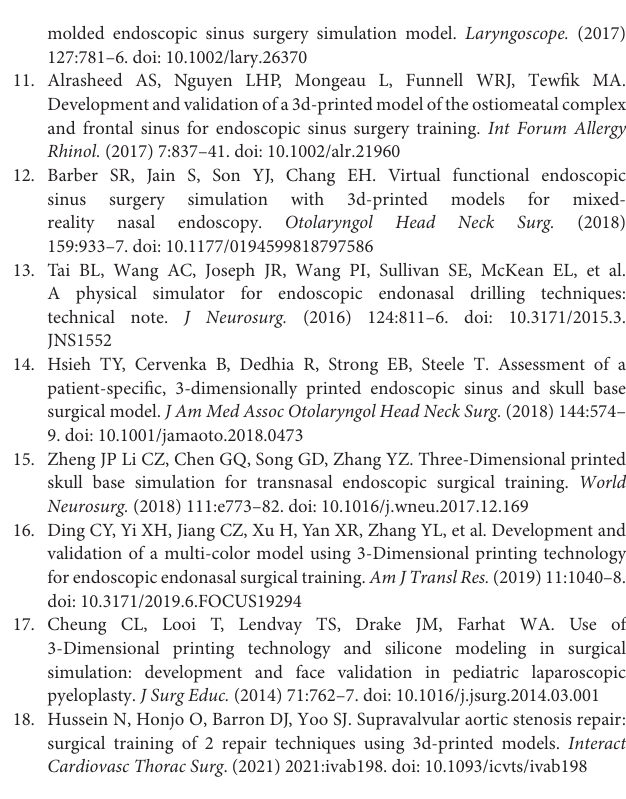
Supplementary Figure 1 | Measurement of the volume of the frontal sinus drainage pathway. (A) 3D sinus models used in the course. The anatomy is identical to that of humans as they are printed from the axial CT scans of patients with chronic rhinosinusitis. The materials mimic human tissue found in the nasal cavity and sinuses. (B–D) CT images of the 3D sinus models were acquired before and after the dissection. 3D computed graphic images of FSPD (sky blue) were created by a 3D image analysis system, SYNAPSE VINCENT with different transparency of the 3D sinus models from 0% (B) to 100% (D) . The volume of FSDP from the level of the superior edge of 3D sinus models to the level of the floor of ANC was quantified. Supplementary Figure 2 | Subjective difficulty of preoperative comprehension of anatomies of frontal recess in each difficulty grade. The subjective difficulty of prediction of FSDP with the Building Block Concept was increased with the higher difficulty grade. P -values for indicated comparisons were determined by t -test. ∗ p < 0.05, ∗∗ p <